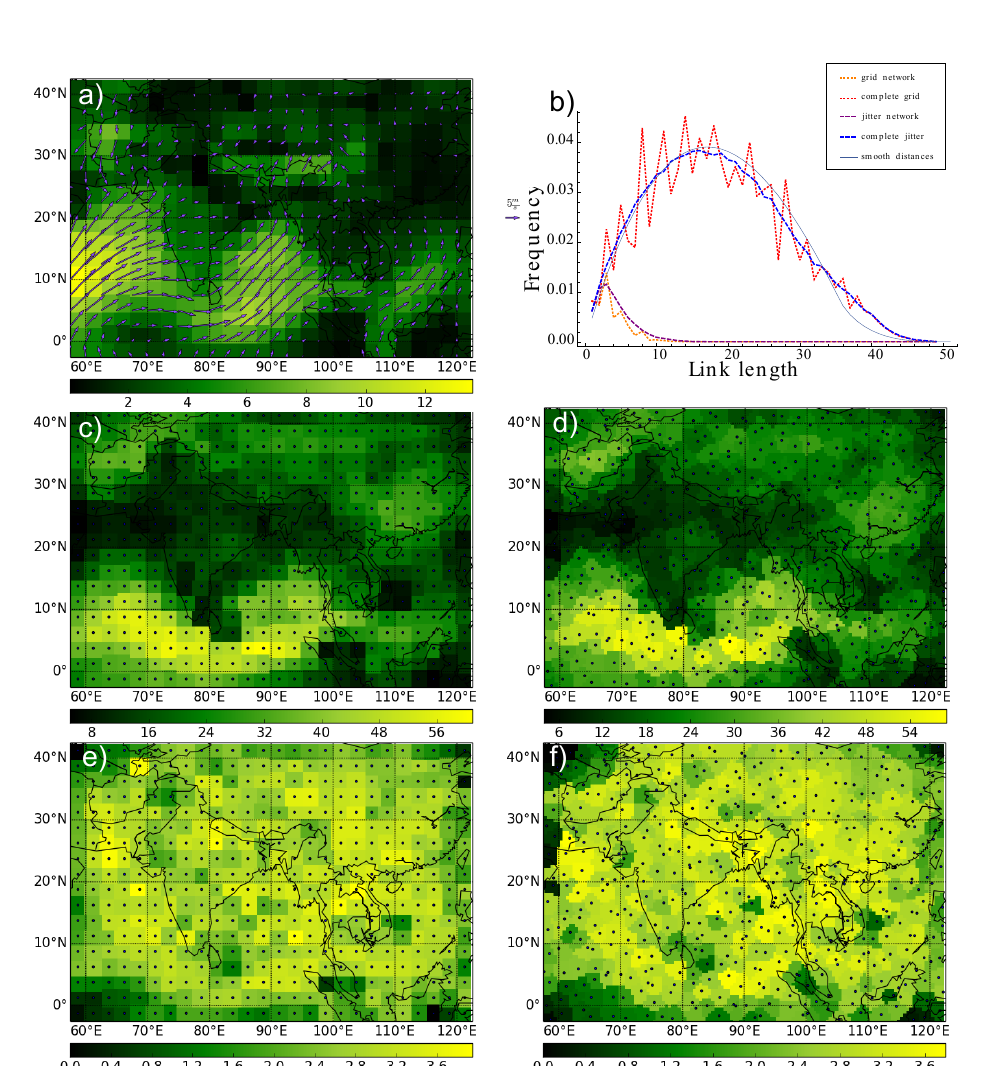
Figure 7. The correlation network of temperature data from NCEP/NCAR on a grid and a jittered grid. (a) Absolute mean wind veloc- ity, (b) link length distributions, (c) degree of the grid network, (d) degree of the jittered network, (e) betweenness of the grid network, (f) betweenness of the jittered